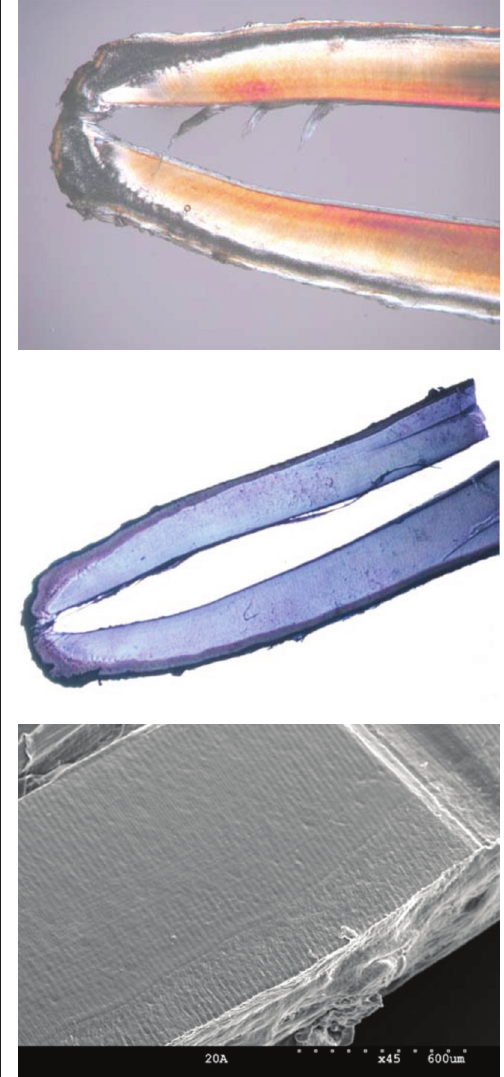
Fig. 3. Buccal-lingual sections of a canine tooth from a harbour seal less than one year old viewed a) with transmitted polarized light b) decalcified and stained, and c) under the SEM. The large pulp cavity is visible in a) and b) which is not yet occluded. Growth lines are also visible within the dentine in each